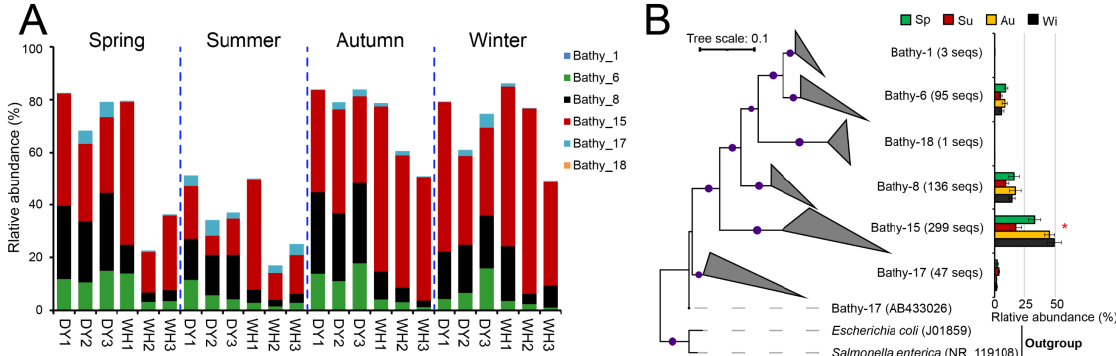
Figure 4. The proportions of Bathyarchaeota subclades ( A ). The maximum likelihood (ML) tree based on 16S rRNA genes shows the phylogeny of Bathyarchaeota subclades, and the bar plots show the specific-taxa relative abundances among four seasons ( n = 6) ( B ). Abbreviations: Sp, spring; Su, summer; Au, autumn; Wi, winter.